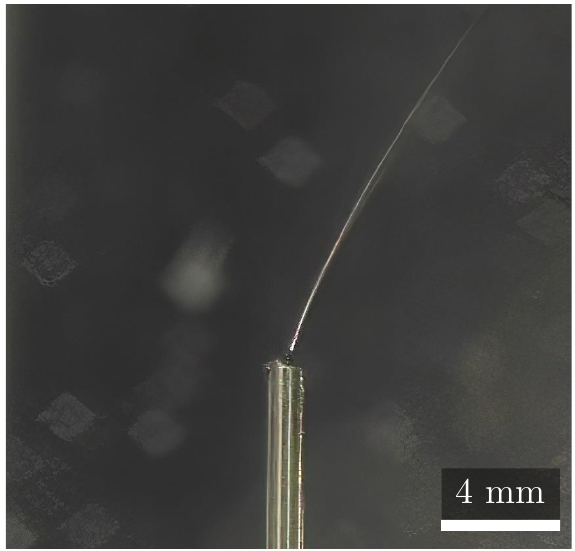
Figure 2. Drawing of a fiber from a forming Taylor cone at the tip of the emitter, in this case, a needle. The fiber is attracted towards the collector, which is no longer captured in this image. The material is 20% PVDF. The heated solution is still liquid in the emitter but during the whipping of the collector and fiber formation the solvent dries, and the PVDF solidifies [17].